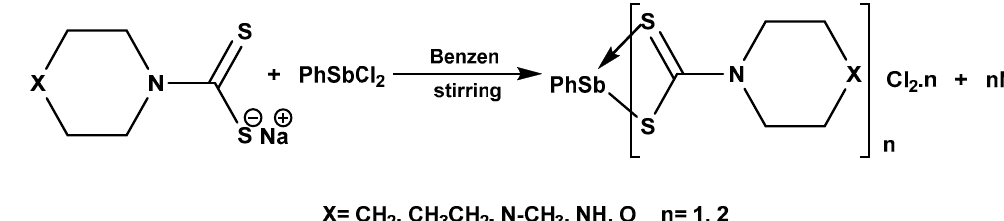
Figure 3. Synthesis of phenylantimony(III) dithiocarbamate complexes.